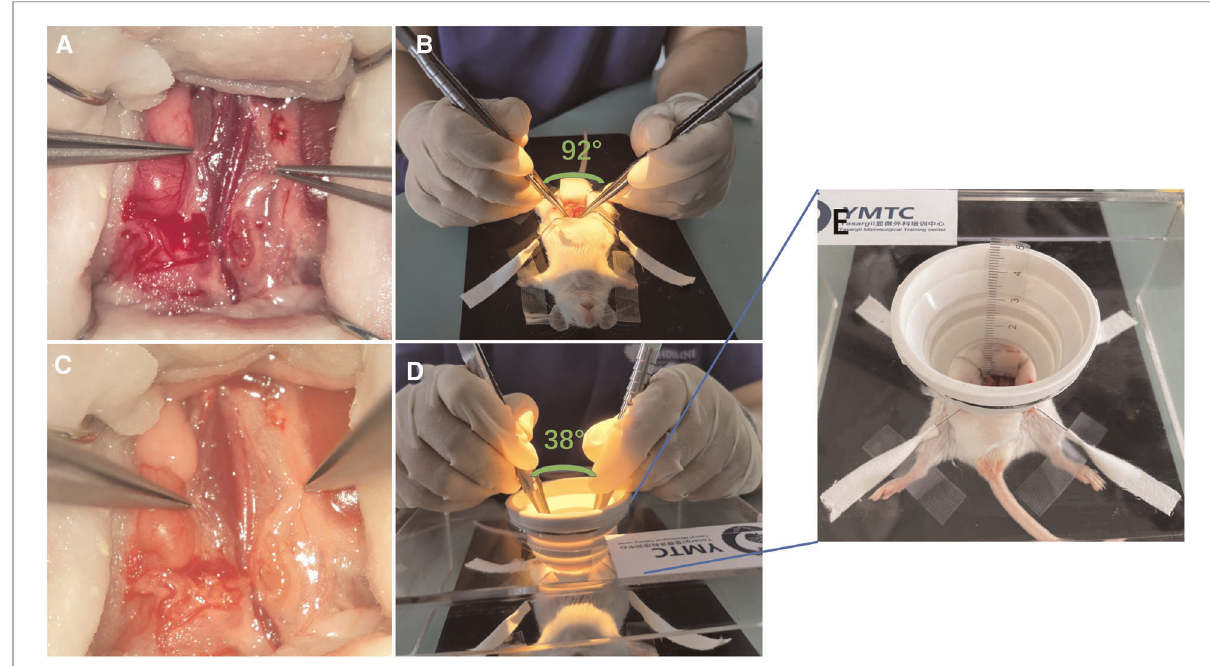
FIGURE 1 Two scenes of vascular anastomosis with different levels of dif fi culty. ( A,B ) Super fi cial anastomosis; the angle between the hands during operation was 38°. ( C,D ) Deep anastomosis; the angle between the hands during operation was 82°. ( E ) Enlarged view of the deep anastomosis device with a depth of about 5